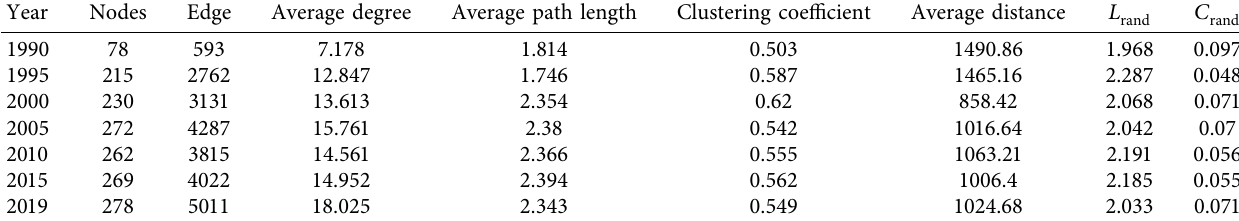
Table 1: USACN complex network properties from 1990 to